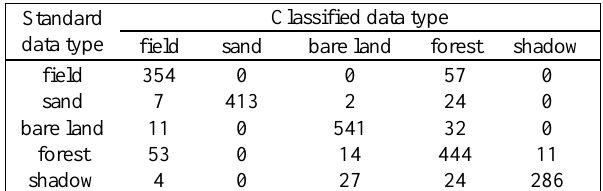
Table 5. the overall classification accuracies and the